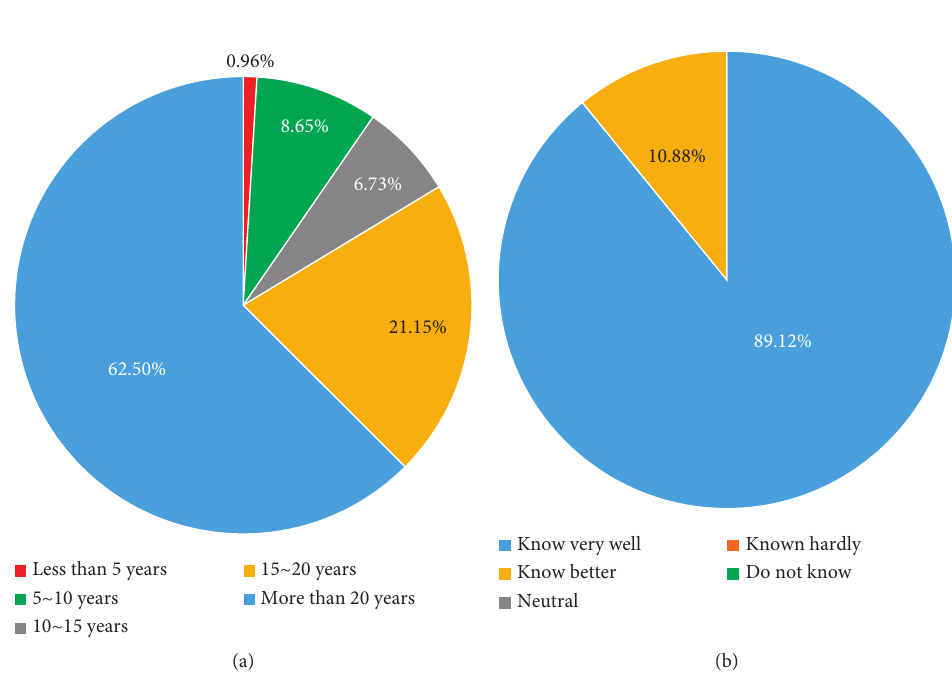
Figure 3: The result of part one. (a) Driving experience. (b) The driver’s understanding of his vehicle’s fuel